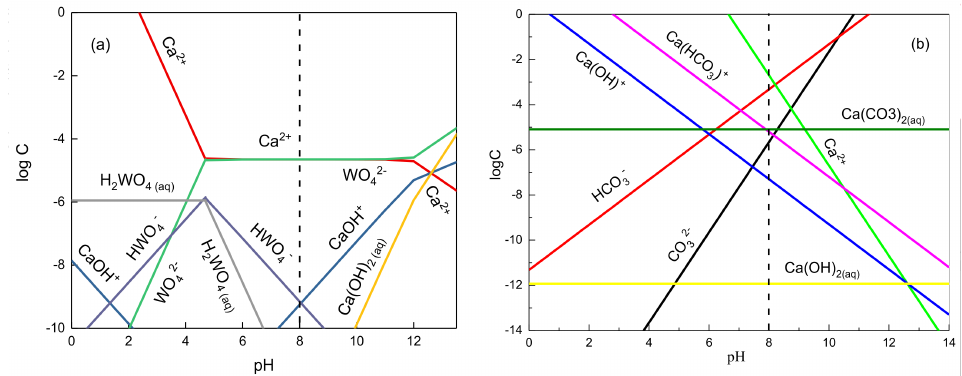
Figure 8. Species distribution diagrams of scheelite ( a ) and calcite ( b